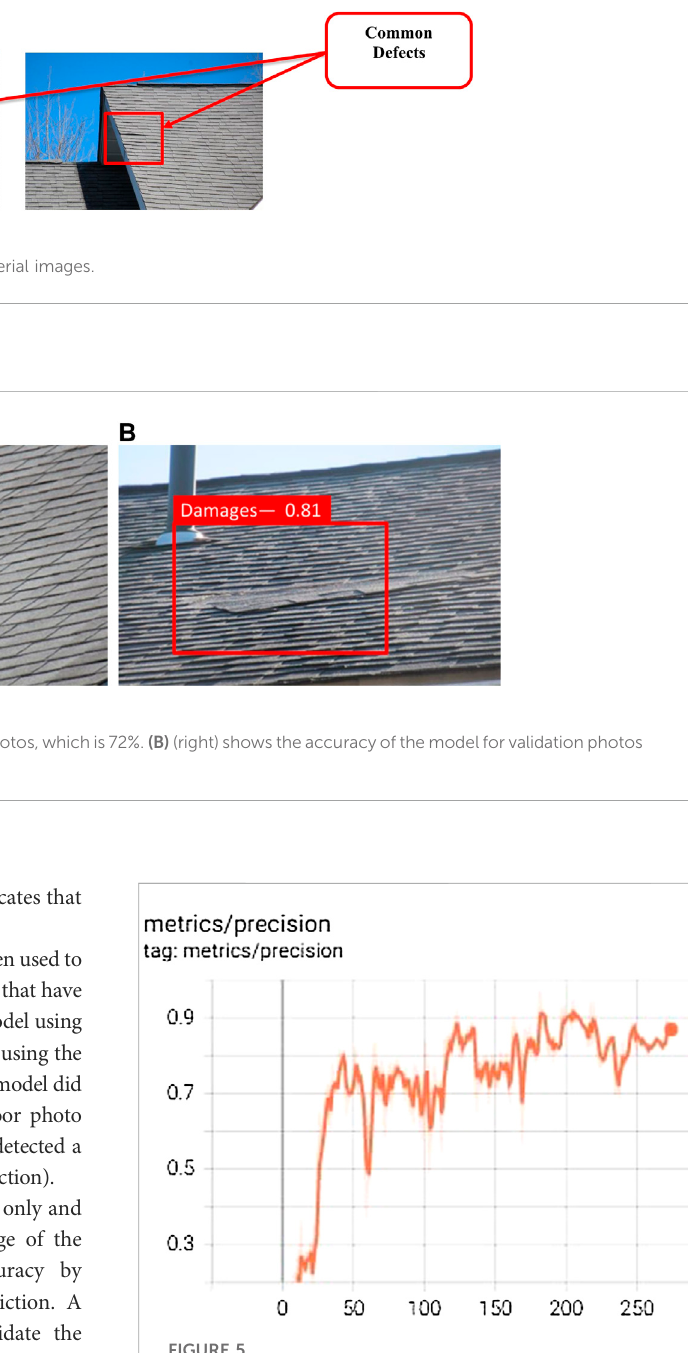
FIGURE 5 The model